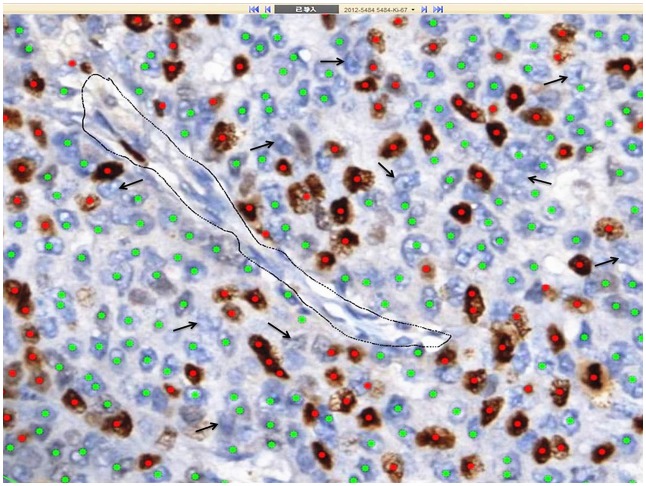
A score area was analyzed by DIA.Positive tumor cells were labeled with red dots and negative tumor cells with green dots. The areas surrounded by black lines were excluded. A few negative tumor cells weren’t recognized (black arrow).